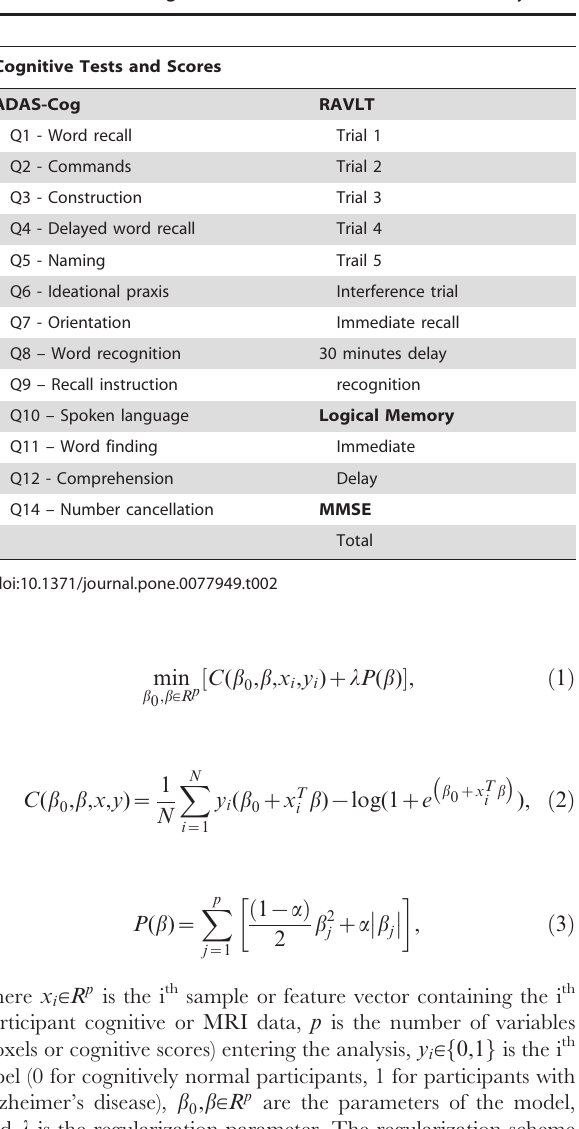
Table 2. ADNI cognitive instruments used in this